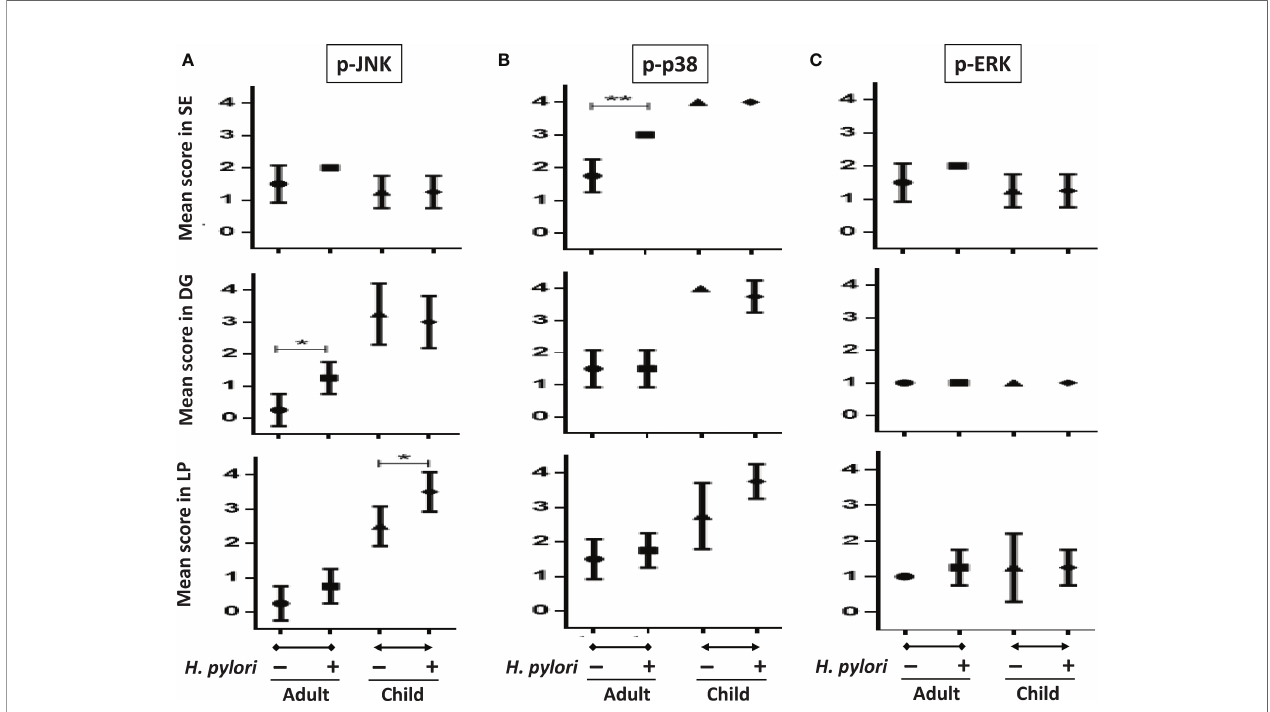
FIGURE 7 | The intensity scores of p-JNK, p-p38, and p-ERK in gastric biopsy samples between children and adults with and without H. pylori infection. Tissue sections including topographical specimens from the antrum in adults and children with and without H. pylori infection (each group, n = 4), were subject to immunohistochemical staining to analyze the intensity of (A) p-JNK, (B) p-p38, and (C) p-ERK MAPK expressions. The sores were strati fi ed into super fi cial epithelium cells (SE), deep glandular cells (DG), and lamina propria (LP) mononuclear and stromal cells in the nucleus. (* P < 0.05, ** P < 0.01).